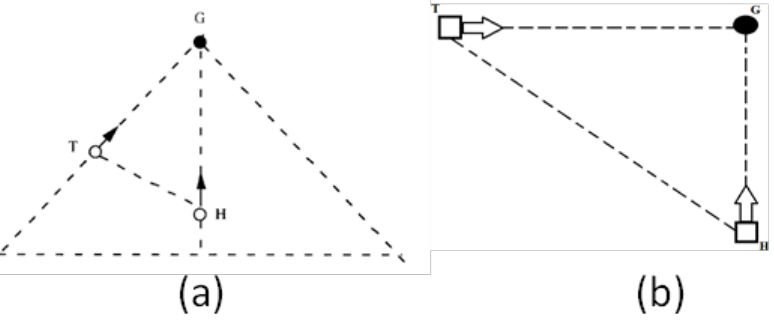
Figure 1. ( a ) Diagram of the experimental task used in [1] that inspired ( b ) the present experiment which required the subject to move the hand (H) on a large vertical touchscreen monitor to collide with a horizontally moving target (T) in goal location G just as the moving target reached G. Note that the interception task in [1] involved moving a computer mouse whereas the present task involved whole arm movement.